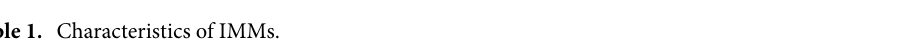
Table 1. Characteristics of